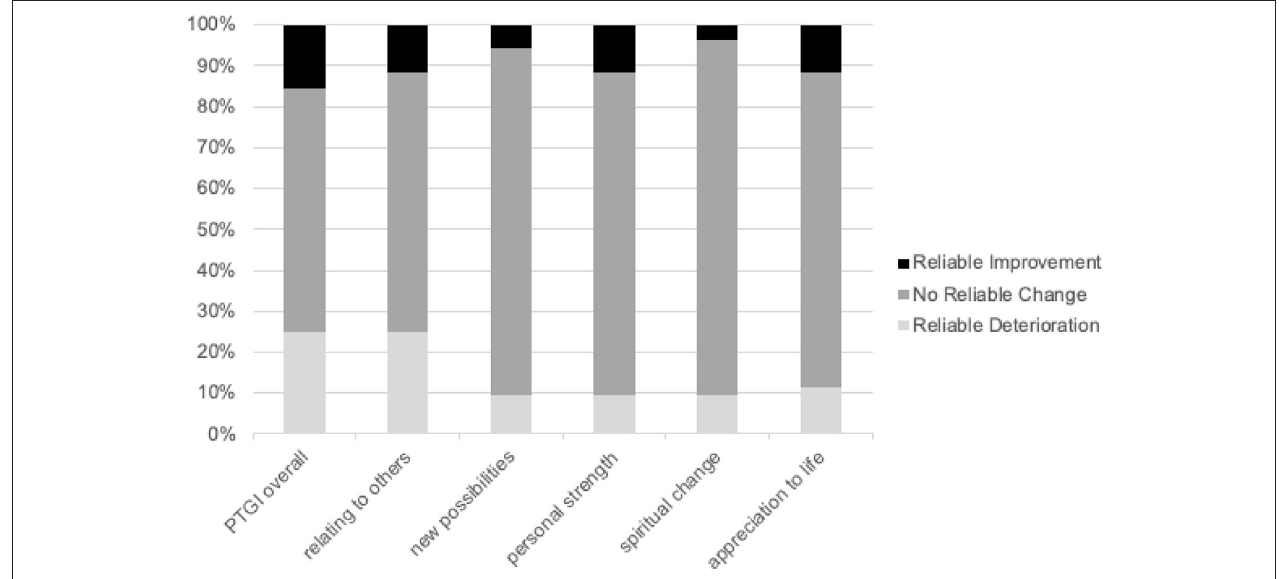
FIGURE 2 | Reliable Change Index (RCI) of PTGI scores over a period of 1 year.